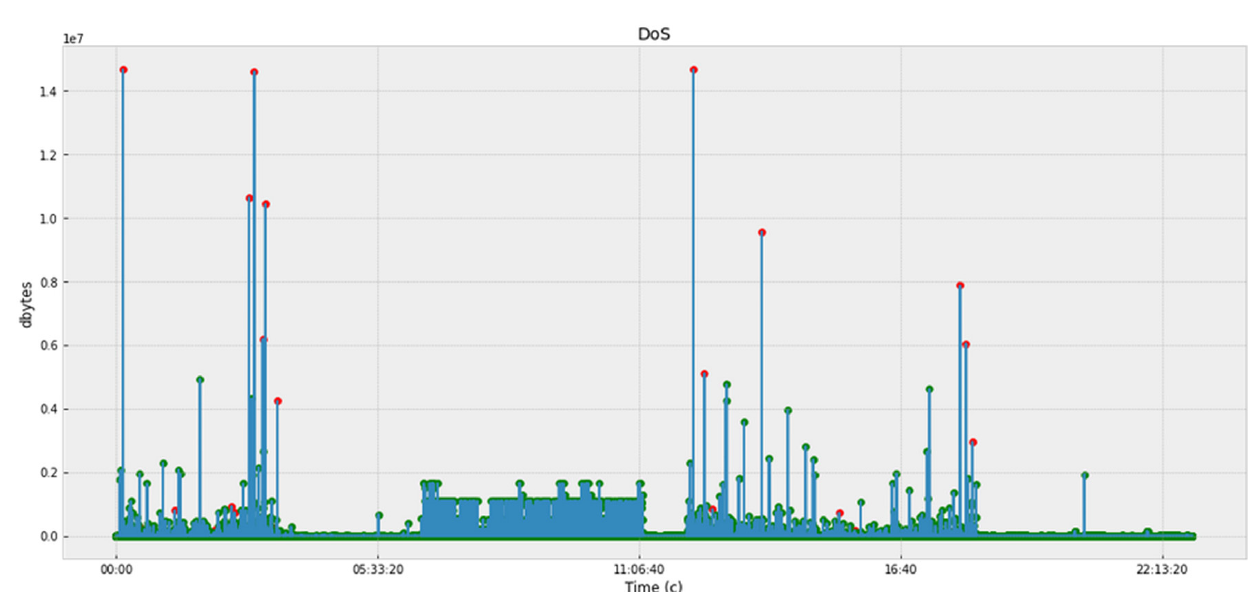
Figure 24. All protocols. Figure 24. All